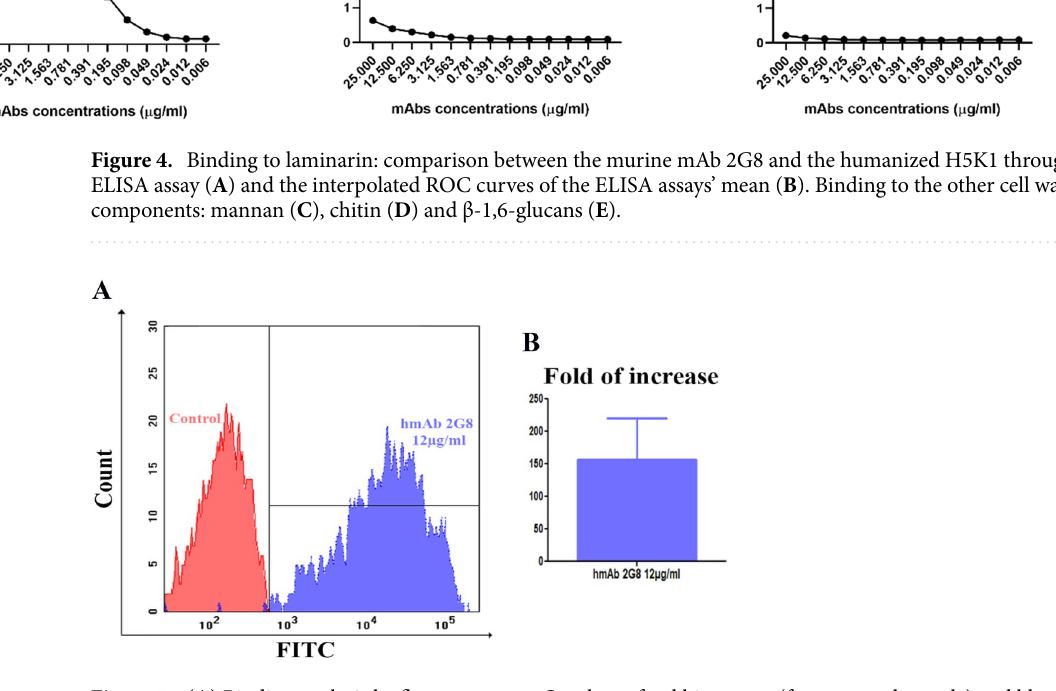
in a 1:1 ratio. Upper contour plots show the experiment related to C. auris not pre-treated with the antibody, whereas the bottom contour plots depict the experiment on Candida labelled by the unconjugated antibody. Briefly, red events represent not engulfing macrophages, blu events represent Candida -engulfing macrophages, and green events the residual free Candida in the samples. Results are statistically reported in scattergrams (Fig. 8B). As it is known, cooperative binding of antibody Fc domains to macrophage FcγR receptors triggers phagocytic cup formation in a process of adhesion and eventually internalization with phagosome closure. Scat- ter grams highlight a higher percentage of engulfing macrophages (Fig. 8B) for all the time points investigated, after labelling Candida auris with the antibody. In fact, opsonization of C. auris may lead to additional FcγRI binding, increased adherence and internalization, and enhanced phagocytosis. This cascade of events in anti- body labelled samples is confirmed also by residual Candida auris which undergoes a reduction at each time point, with the best result of more than half reduction after 180 min (Fig. 8C). This highlights that the H5K1 immunomodulatory effects are not restricted to the percentage of actively phagocyting macrophages. Finally, as